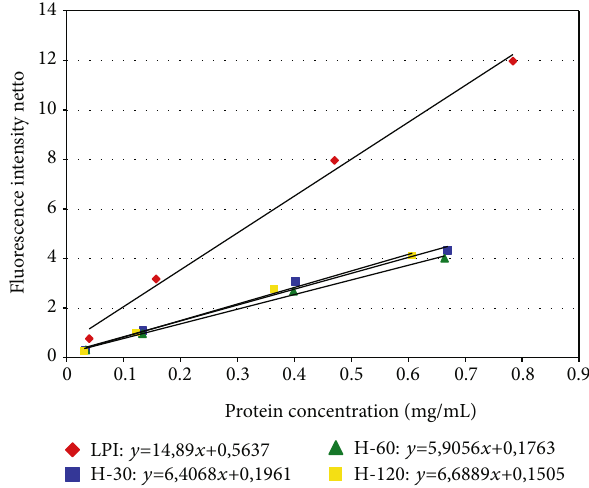
Figure 4: Surface hydrophobicity analysis results of LPI and its hydrolysates (H-30, H-60, and